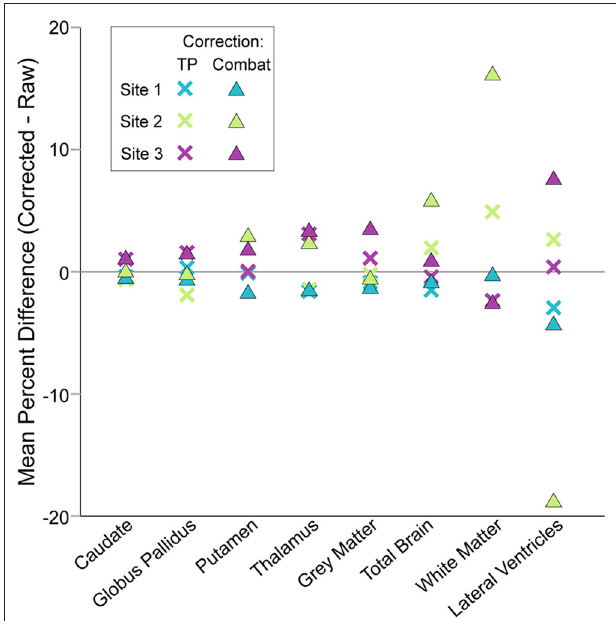
FIGURE 6 | Mean percent changes between corrected and raw volumes by site, structure and correction method. Traveling phantom and ComBat correction methods yielded similar results for deep gray matter structures, resulting in small magnitude changes in volumes. Conversely, changes in lateral ventricle, white matter and total brain volumes after ComBat correction were larger than after traveling phantom based correction. Note that negative values for lateral ventricle volume produced by ComBat correction were excluded prior to calculation of mean percent difference